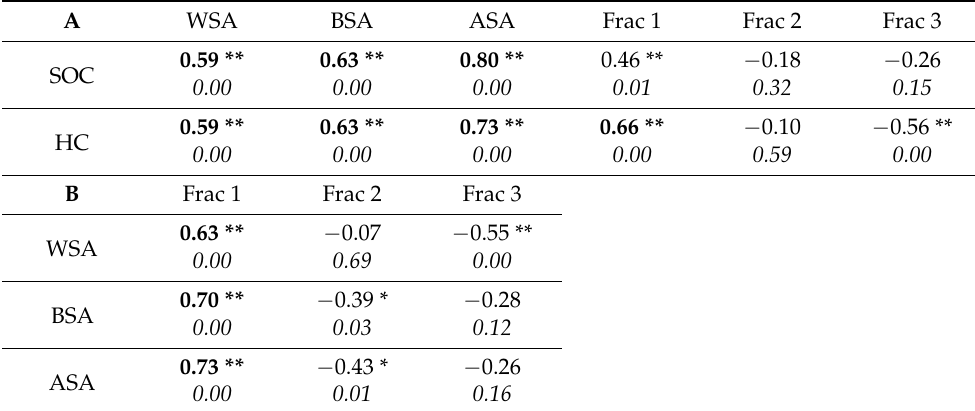
Table 13. Pearson’s